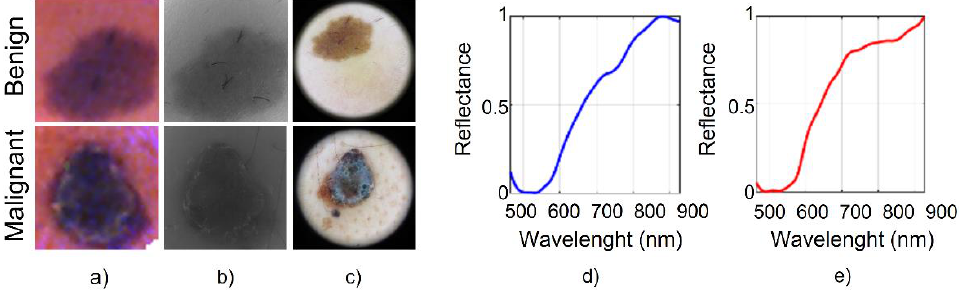
Figure 1. Example images from the dataset. ( a ) Pseudo-RGB images obtained with the HS camera, ( b ) grayscale image captured with the monochromatic sensor, ( c ) RGB images obtained with the digital dermoscopic camera, ( d ) average spectral signature of benign lesion, ( e ) average spectral signature of malignant lesion.